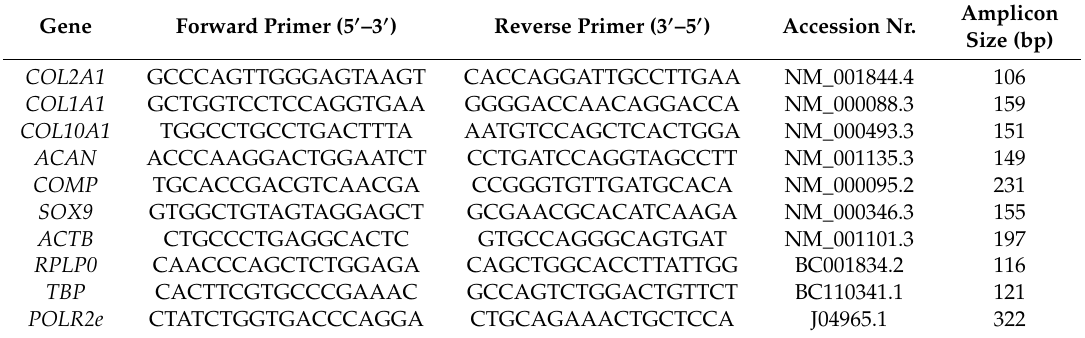
Table 1. Gene specific primers used for quantitative real-time